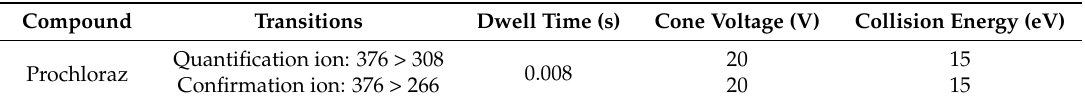
Table 1. Ion transitions used for quantification (multiple reaction monitoring modes (MRM) 1) and confirmation (MRM2), dwell time, cone voltages, and collision energies for MS.